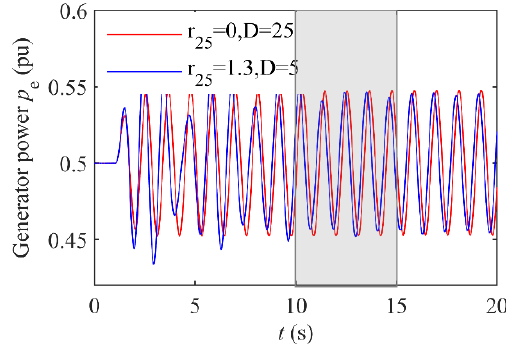
Figure 6. Damping equivalence calculation.